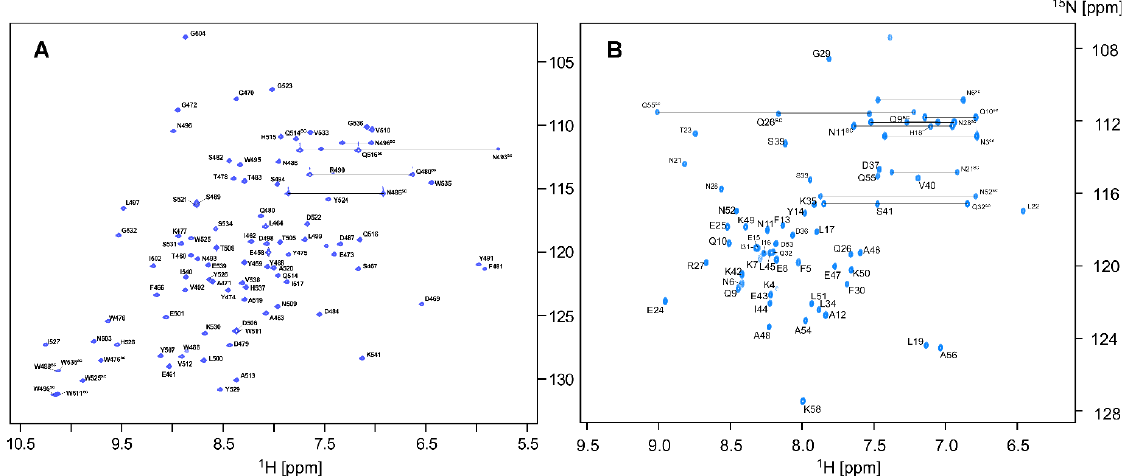
Figure 1. ( A ) Two-dimensional [ 1 H, 15 N]-HSQC spectrum of [20% 13 C, 100% 15 N]-labeled CBM64 recorded at the 1 H frequency of 850 MHz, 303 K with the assignment using one letter amino-acid codes (residues 458–541). ( B ) Two-dimensional [ 1 H, 15 N]-HSQC spectrum of [20% 13 C, 100% 15 N]-labeled SpaC with the assignment using one letter amino-acid codes (residues 4 – 58). The sidechains are marked by “ sc ” . Identified sidechain amides of glutamine (Q sc ) and asparagine (N sc ) are indicated by horizontal lines.